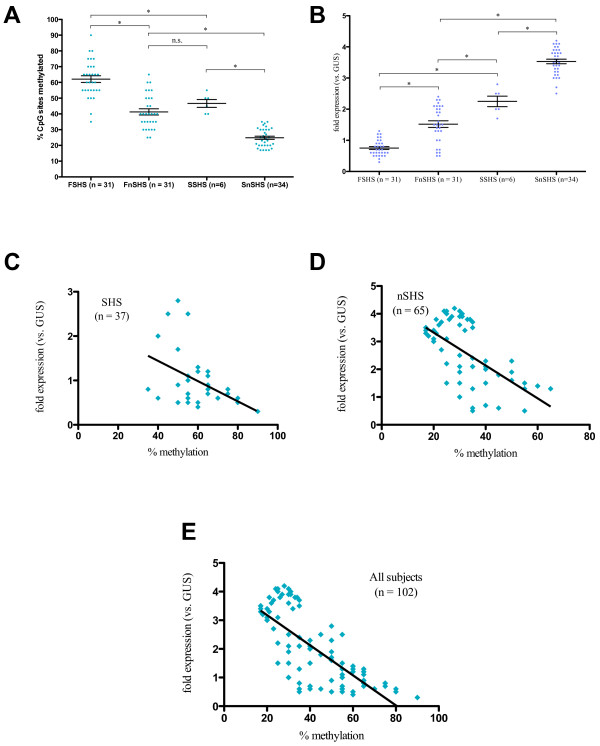
Methylation and expression of IFN-γ in T effector cells (Teffs) of all subjects. A. Comparison of overall methylation of examined cytosine nucleotide neighboring guanine (CpG) sites in IFN-γ in Teffs between Fresno subjects exposed to secondhand smoke (SHS) (FSHS) (n = 31), Fresno subjects not exposed to SHS (FnSHS) (n = 31), Stanford subjects exposed to SHS (SSHS) (n = 6), and Stanford subjects who were not exposed (SnSHS) (n = 34) groups. Methylation is reported as percent methylated CpG sites out of 6 total examined CpG sites (Figure 
1); the cutoff for positive methylation at each site was set at 70% of all sequencing reactions. Error bars represent standard error of the mean (SEM). B. Comparison of expression of IFN-γ in Teffs between FSHS, FnSHS, SSHS, and SnSHS groups. Expression is reported as fold expression relative to the expression of the housekeeping gene beta-glucuronidase (GUS). Error bars represent SEM. C. Linear regression analysis of IFN-γ expression in Teffs vs. % methylation of IFN-γ from all SHS subjects. D. Linear regression analysis of IFN-γ expression in Teffs vs. % methylation of IFN-γ from all nSHS subjects. E. Linear regression analysis of IFN-γ expression in Teffs vs. % methylation of IFN-γ from all subjects. FSHS, Fresno group exposed to secondhand smoke; FnSHS, Fresno group not exposed to secondhand smoke; SSHS, Stanford group exposed to secondhand smoke; SnSHS, Stanford group not exposed to secondhand smoke; n.s., not significant. *P < 0.05.